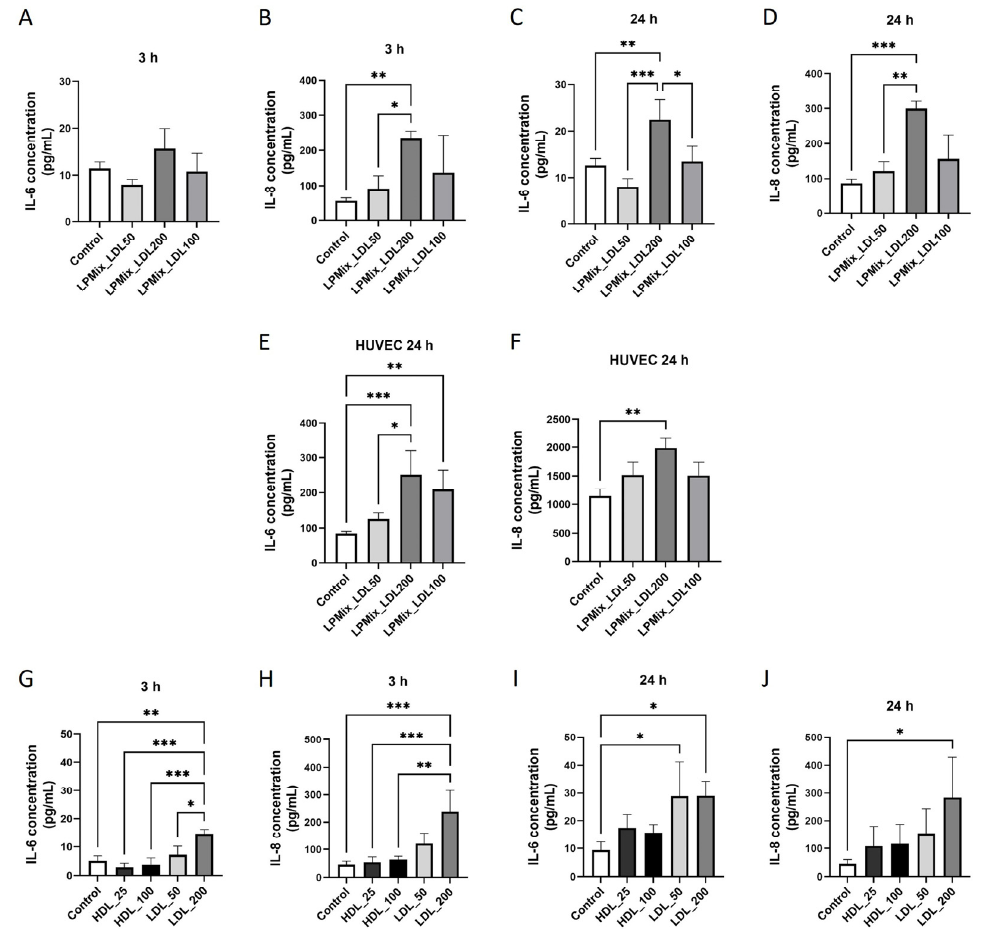
Figure 1. LDL increases the secretion of IL-6 and IL-8 in endothelial cells. ( A – D ) IL-6 ( A , C ) and IL-8 ( B , D ) protein levels in supernatants of EA.hy926 cells incubated with LPMix supplemented with LDL in different concentrations for 3 h ( A , B ) or 24 h ( C , D ), as quantified by ELISA. n = 3 ( A , C ), n = 4 ( B , D ), one-way ANOVA. ( E , F ) Quantification of IL-6 ( E ) and IL-8 ( F ) protein levels in supernatants of HUVECs incubated with LPMix supplemented with LDL in different concentrations for 24 h. n = 3, one-way ANOVA. ( G – J ) Determination of IL-6 ( G , I ) and IL-8 ( H , J ) protein levels in supernatants of EA.hy926 cells after incubation with high or low concentrations of isolated HDL or LDL for 3 h ( G , H ) or 24 h ( I , J ) by ELISA. n = 3 ( G , I ), n = 4 ( F , H ), one-way ANOVA. All graphs shown as mean ± SD, * p < 0.05, ** p < 0.01, *** p <